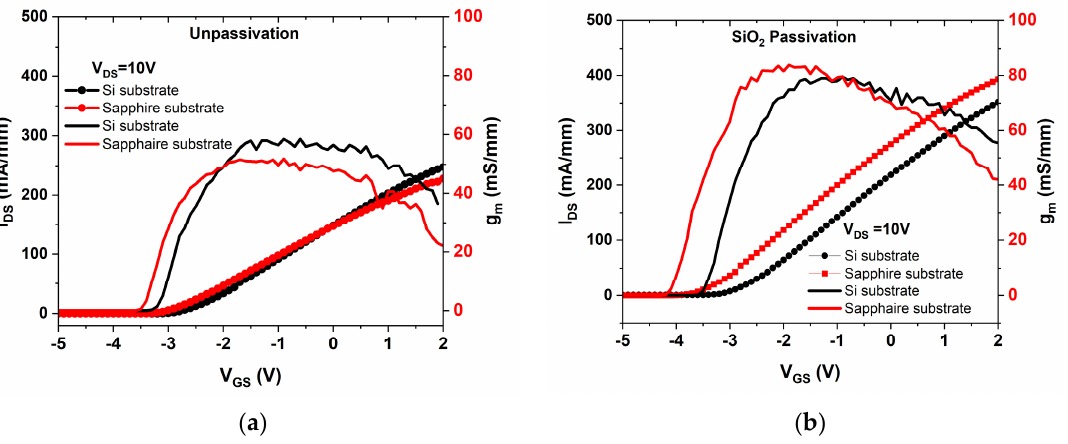
Figure 3. The off ‐ state I GS ‐ V DS curves of AlGaN/GaN HEMTs on Si and sapphire substrates ( a ) with ‐ Figure 3. The off-state I GS -V DS curves of AlGaN/GaN HEMTs on Si and sapphire substrates out and ( b ) with SiO 2 passivation. ( a ) without and ( b ) with SiO 2 passivation.